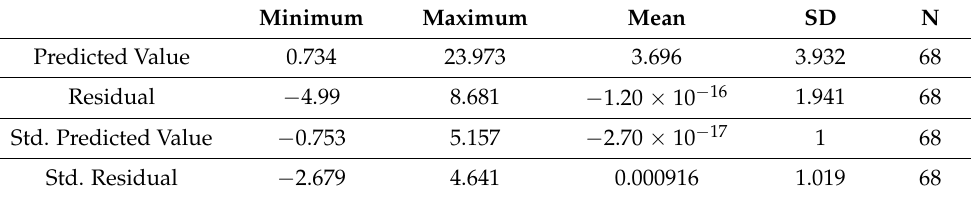
Table 16. Horizontal dry plate method and wet candle method—statistic of